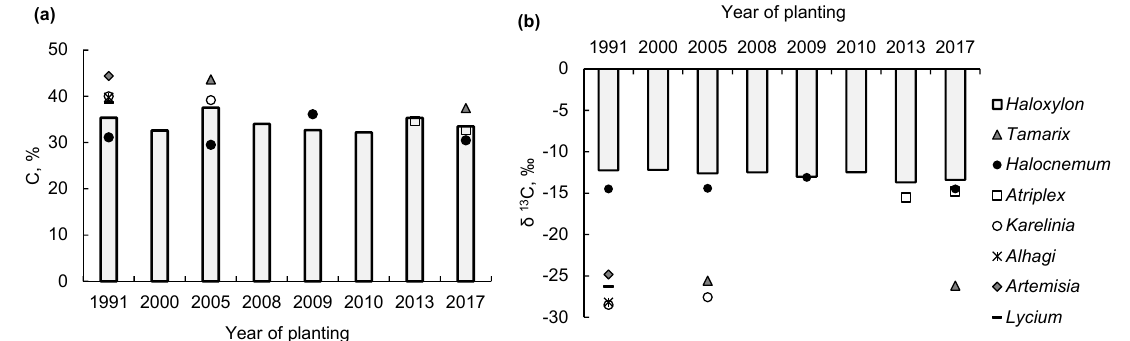
Figure 2. Carbon concentration ( a ) and δ 13 C ( b ) in photosynthetic organs of plant species identified in the northern Aralkum sites afforested with Haloxylon aphyllum during 1991–2017 (plantations aged 1–27 years).